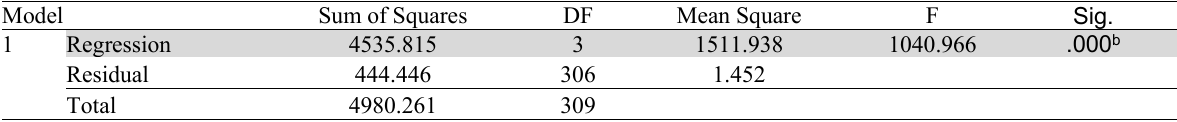
The results of ANOVA a test